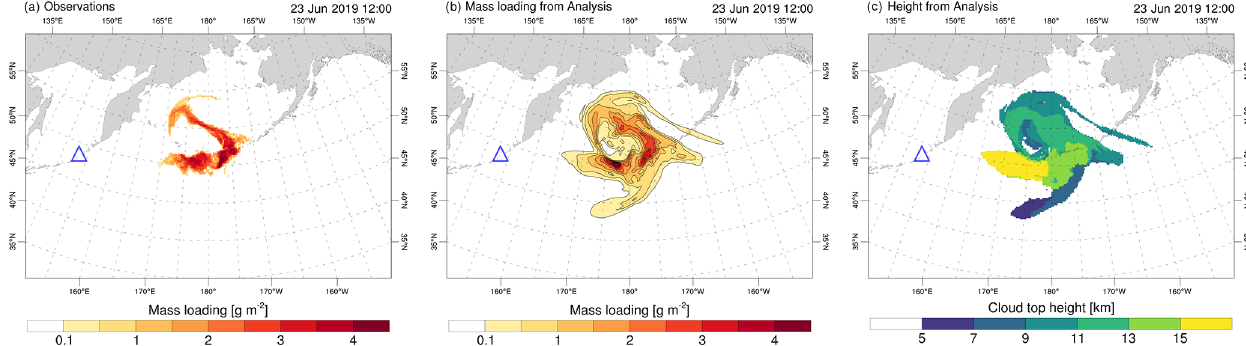
Figure 10. SO 2 cloud for the 2019 Raikoke eruption on 23 June at 12:00UTC. Observed (a) and modelled (b) mass loadings are compared at the same instant of time. In addition, the cloud top height (c) derived from the analysed state is also shown. The LETKF run was configured assuming a localisation radius of L R = 2 ◦ and an assimilation frequency of 3h, starting on 22 June 2019 at 12:00UTC.